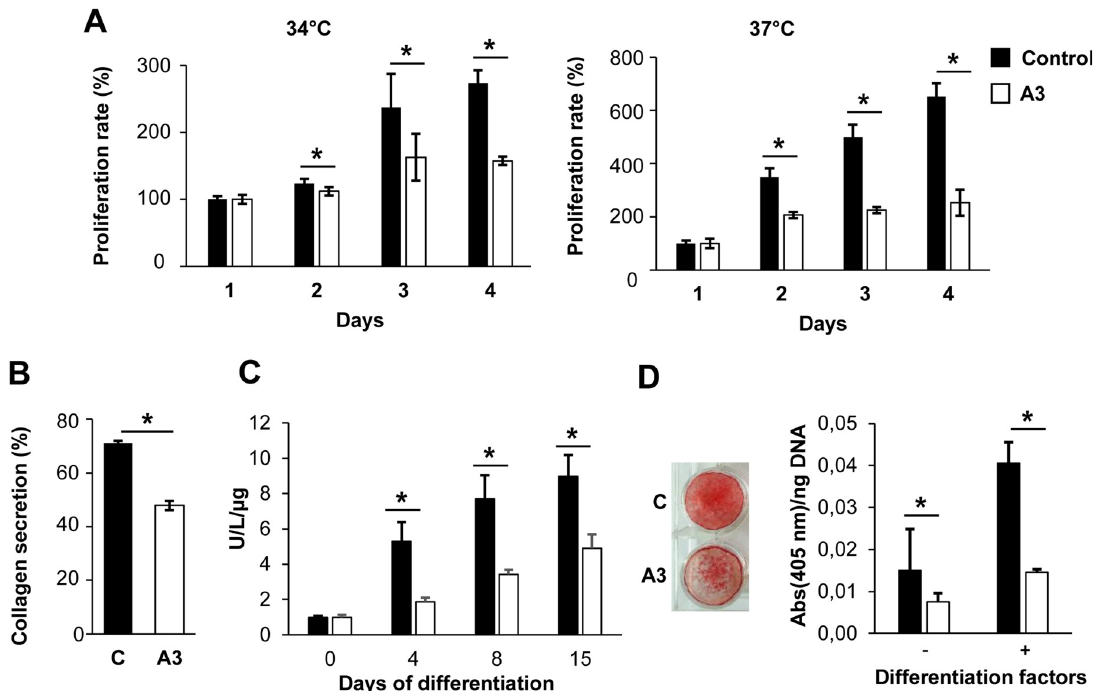
Fig 4. Cell proliferation, collagen secretion and matrix mineralization analysis. (A) Analysis of cell proliferation was performed both at 34˚C and 37˚C. A significant impairment of proliferation was detected in the KO clone A3 at both temperatures after 2, 3 and 4 days of culture. (B) Collagen secretion was evaluated upon cells 3 H-proline labelling. A significant reduction of collagen secretion was detected in mutant clone compared to control cells. (C) The activity of ALP was significantly reduced in A3 mutant clone compared to WT at 4, 8 and 15 days of differentiation. All data were normalized to day 0. (D) The mineralization was analysed by alizarin red S staining. The mineral amount was significantly reduced in KO clones with respect to WT. � p < 0.05.